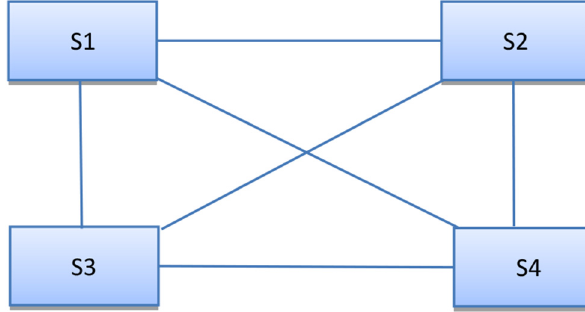
Fig. 5. Interaction model in e-health network.